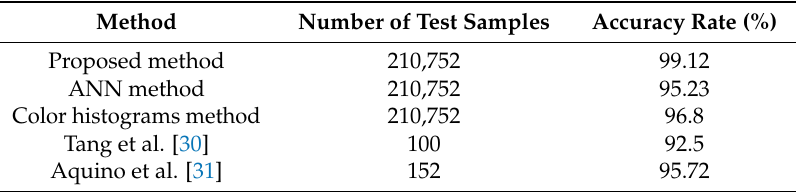
Table 11. Comparison of the segmentation accuracy of the proposed algorithm with respect to other recent research